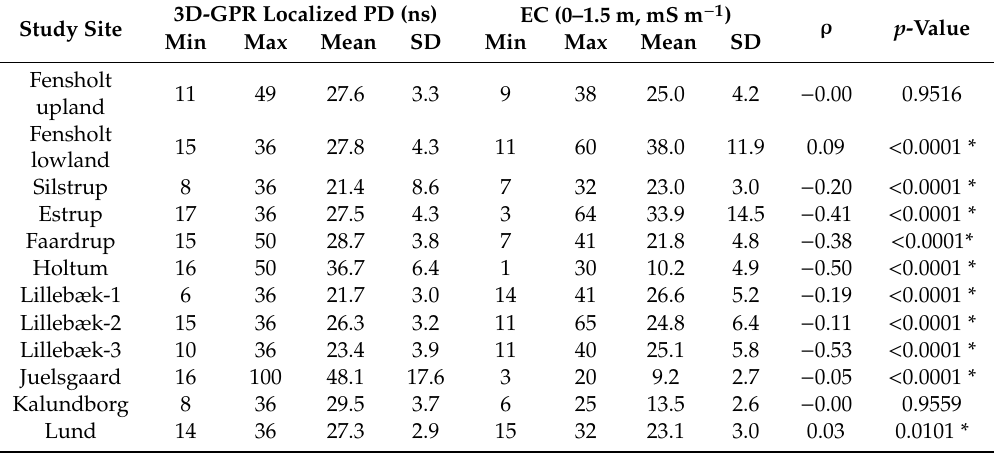
Table 4. Summary statistics and Spearman’s rank correlation coe ffi cient ( ρ ) of the 3D-GPR